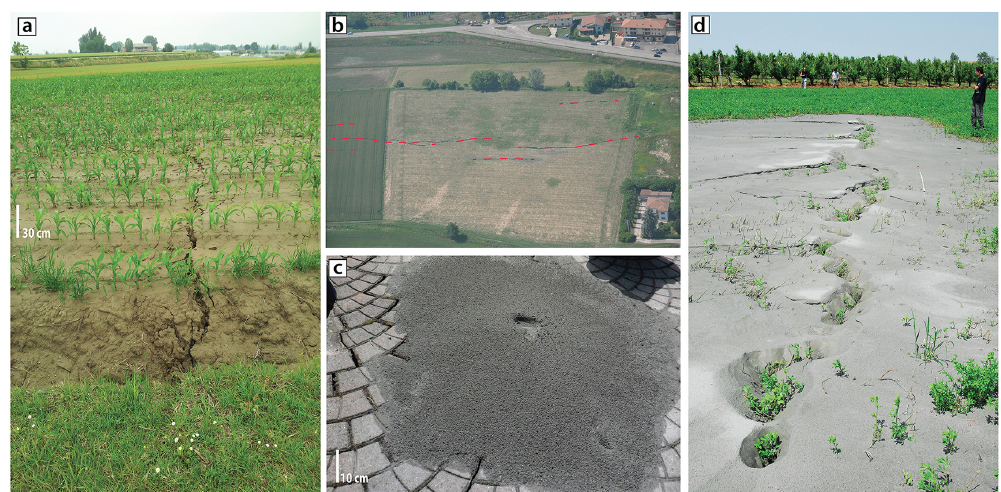
Figure 2. Examples of observed liquefaction phenomena produced by the 2012 Emilia seismic sequence: (a, b) fractures; (c) single sand volcano; (d) alignment of sand volcanoes (photos courtesy of EMERGEO Working Group,